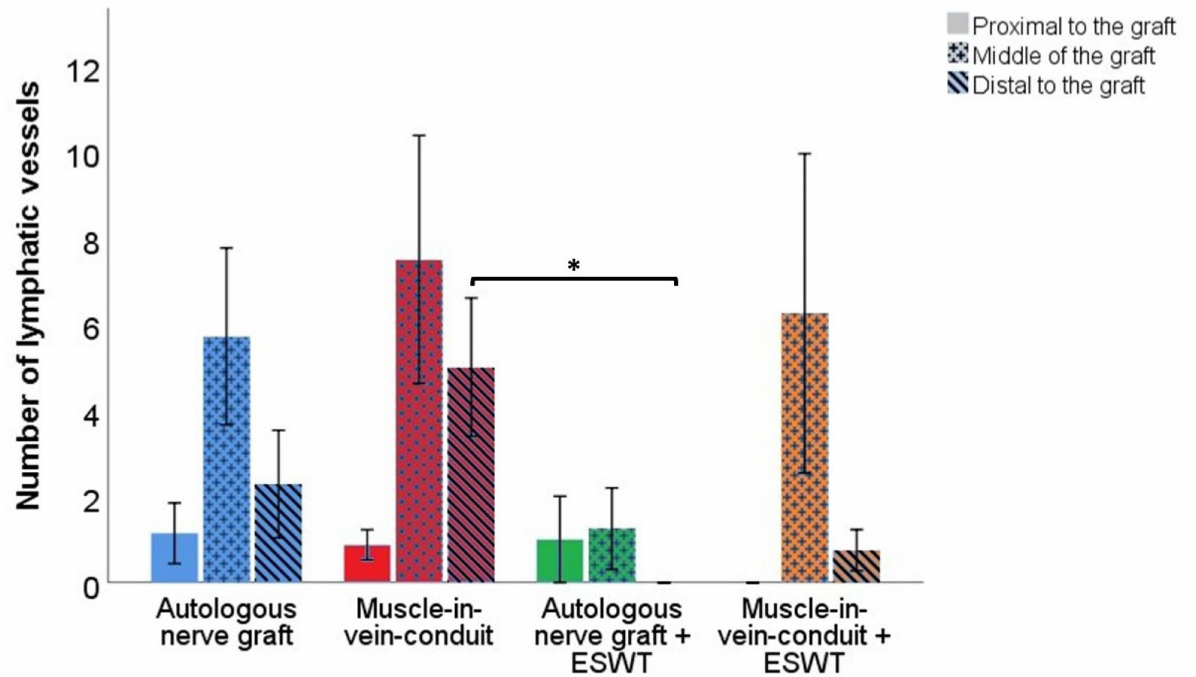
Figure 12. Number of lymphatic vessels in different segments of the reconstructed right median nerve 12 weeks following resection of a 7 mm segment of the right median nerve and immediate reconstruction with an autologous nerve graft ( n = 8), a muscle-in-vein conduit ( n = 8), an autologous nerve graft + ESWT (autologous nerve graft with postoperative extracorporeal shockwave therapy) ( n = 5) or a muscle-in-vein conduit + ESWT (muscle-in-vein conduit with postoperative extracorporeal shockwave therapy) ( n = 4). Statistical evaluation was performed with the nonparametric Kruskal– Wallis test and the Dunn–Bonferroni post hoc test. For subgroup analysis of identical reconstructive approaches, the Mann–Whitney U test was used. Repeated measurements of the same group were compared by means of the nonparametric Friedman test. Note: * p <